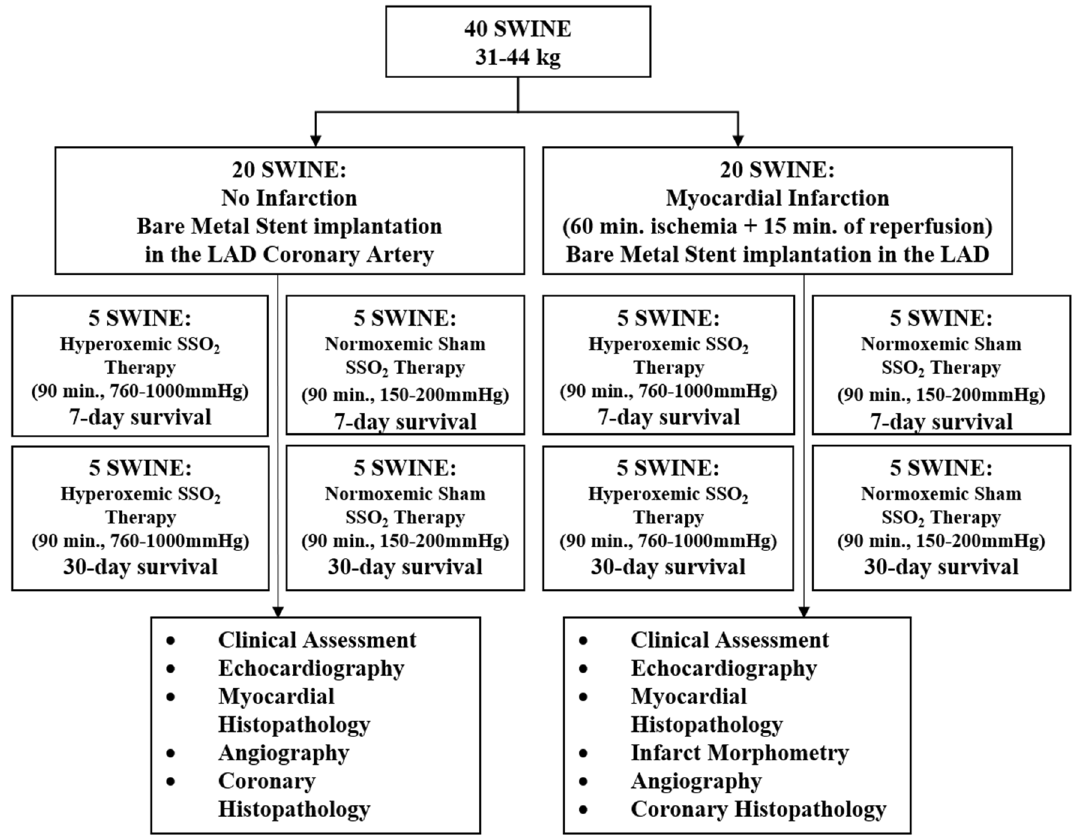
Figure 1. Essentials of study design in form of a flow